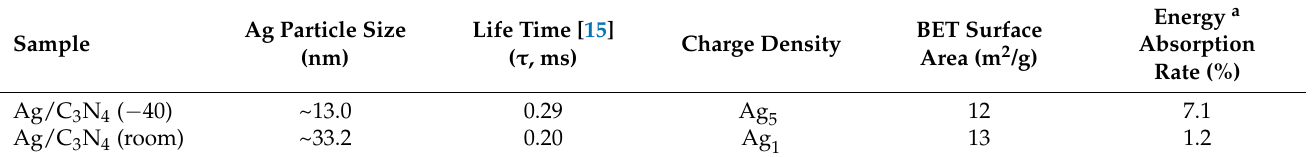
Table 1. The properties of Ag/C 3 N 4